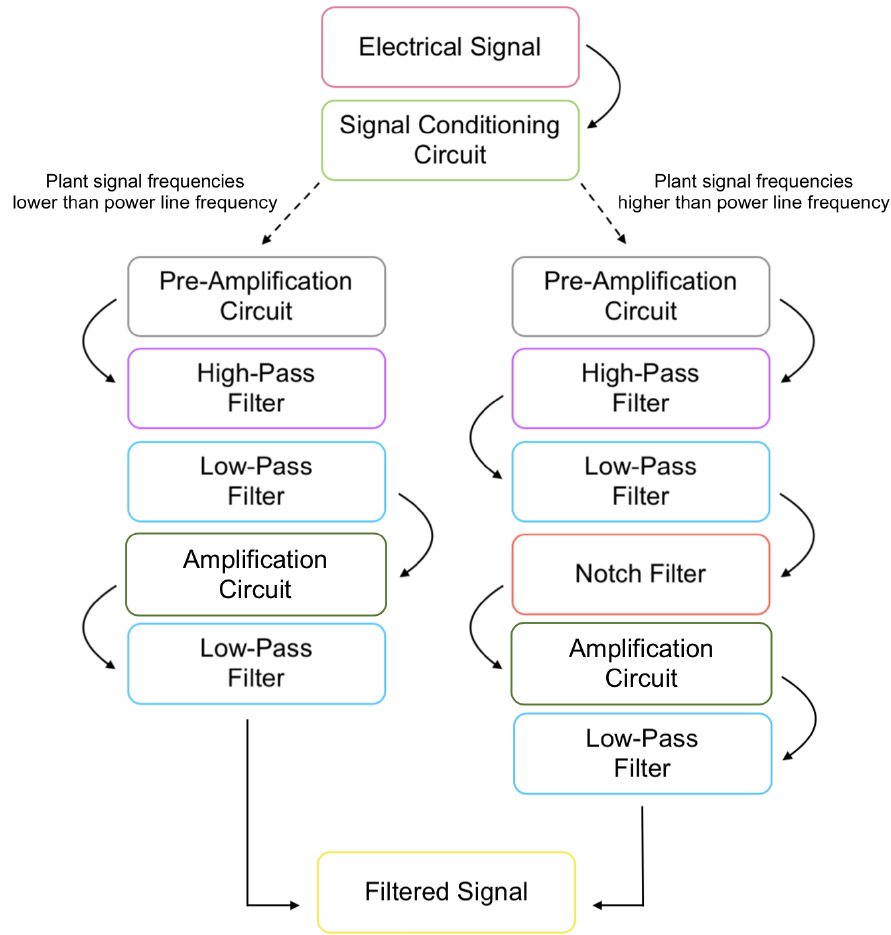
Figure 3. Flowchart of the proposed